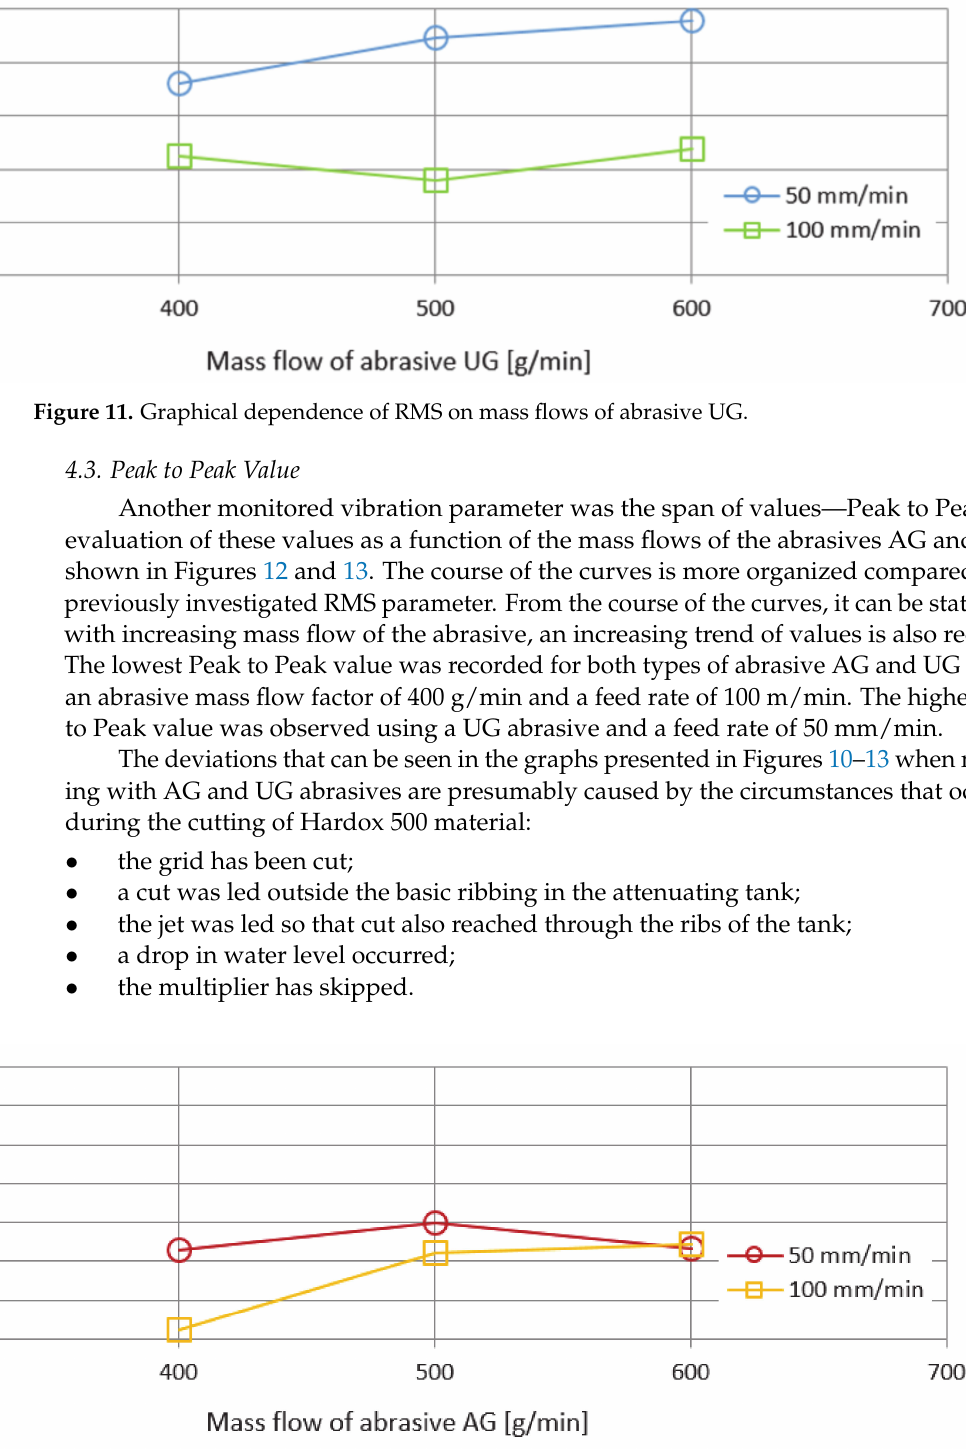
Figure 12. Graphical dependence of Peak-to-Peak on mass flows of abrasive